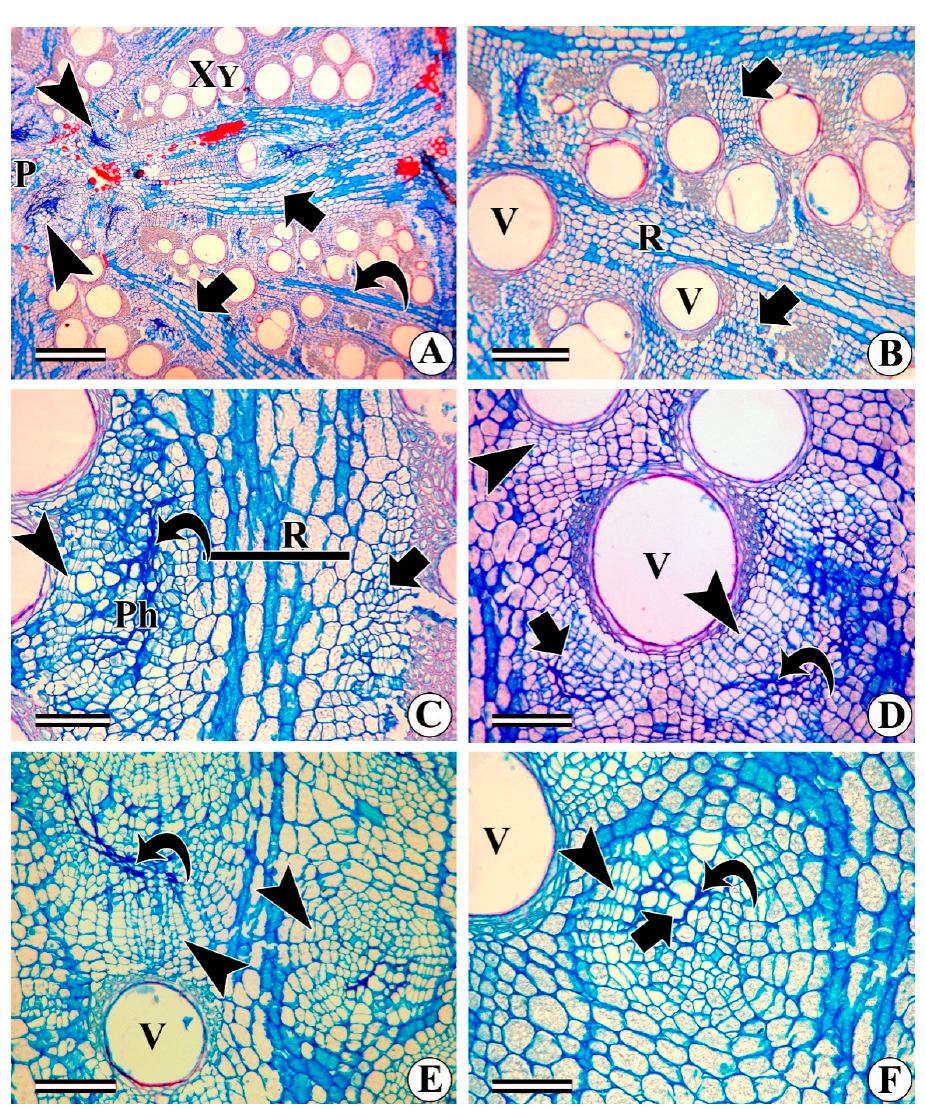
Figure 5. Transverse view of the thick stems of Coccinia grandis showing various stages of parenchyma dedifferentiation. ( A ) Structure of secondary xylem before the initiation of interxylary phloem in a 15 mm thick stem. Arrowheads indicate phloem (bicollateral) on the pith margin, arrows indicate medullary rays, and the curved arrow shows the secondary ray. ( B ) Enlarged view of Figure 5A showing the structure of the secondary xylem. Arrows indicate unlignified parenchyma patches. ( C ) Dedifferentiation of axial parenchyma adjacent to the rays forming files of meristematic cells (arrowhead). The curved arrow indicates non-conducting and crushed phloem. The arrow shows the divisions in the axial parenchyma followed by the differentiation of phloem elements. The horizontal bar (R) indicates the xylem ray. ( D ) Axial parenchyma adjacent to the vessels showing meristematic activity (arrowheads), phloem elements (arrow), and crushed phloem (curved arrow). ( E ) Part of the secondary xylem showing the meristematic activity (arrowheads) of the axial parenchyma and the formation of phloem elements. The curved arrow indicates the crushed sieve elements. ( F ) Enlarged view of Figure 5E showing the circular arrangement of meristematic cells (arrowhead), sieve element (arrow), and crushed phloem (curved arrow). Abbreviations : Ph = secondary phloem, P = pith, R = xylem ray, V = vessel, XY = secondary xylem. Scale bars: A = 500 µm; B, E = 200 µm; C, D, F = 100 µm.